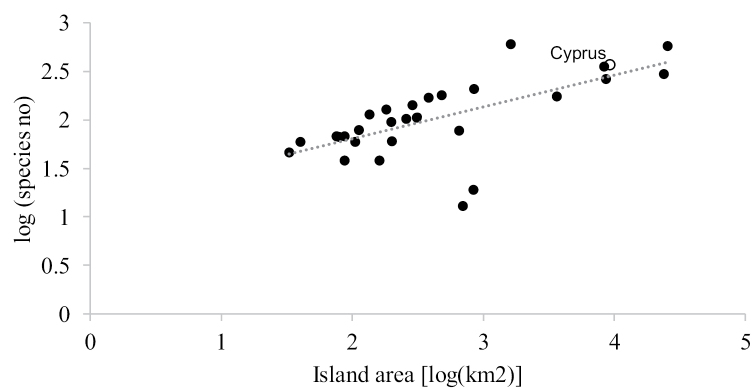
Diversity of bee fauna in 30 Mediterranean islands as a function of island area (logarithm transformed data). See text for the islands and their untransformed bee species numbers. Cyprus represented by the open circle.